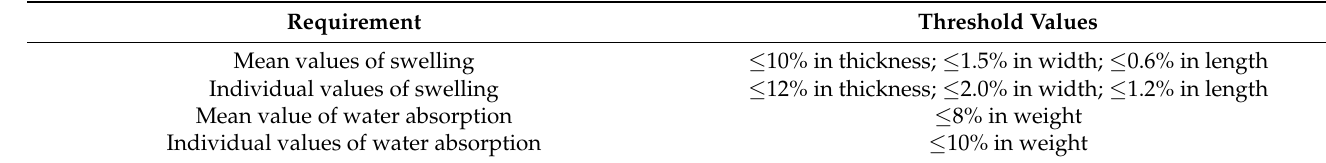
Table 7. Requirements for swelling and water uptake (DIN EN